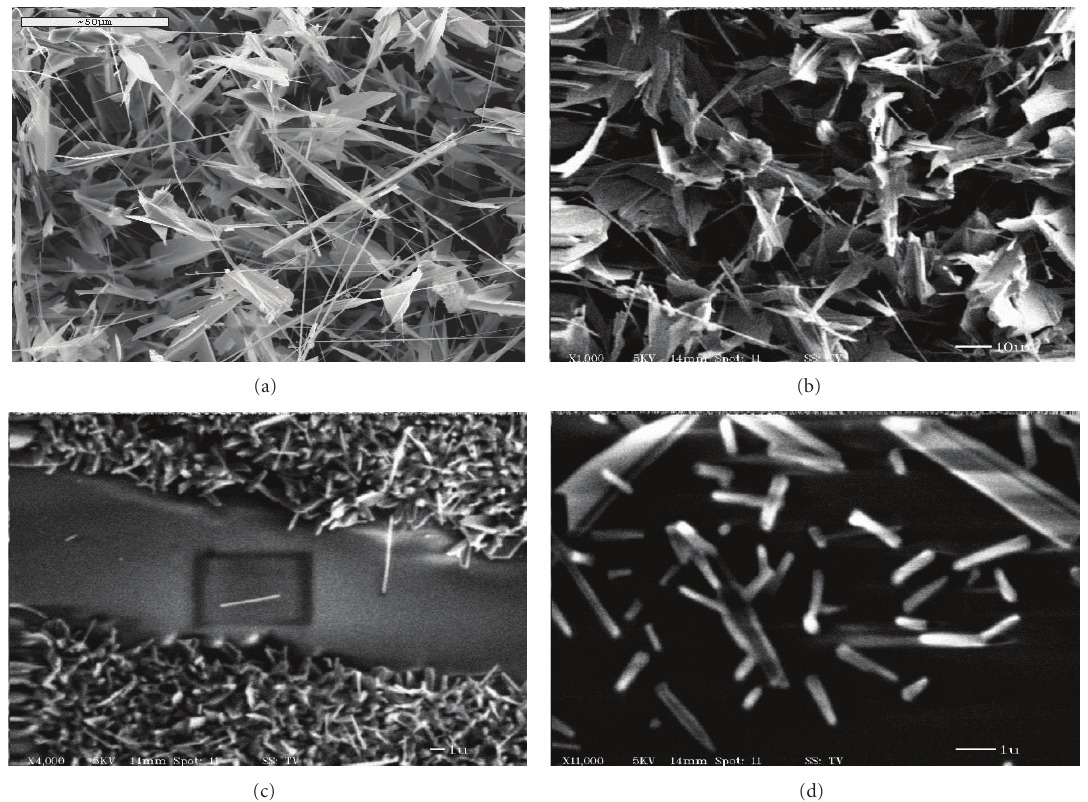
Figure 3: Secondary electron images of as-grown ZnO. (a) on silicon (100), (b) on fused silica (SiO 2 ), and (c) and (d) on gold-covered fused silica (Au/SiO 2 ).